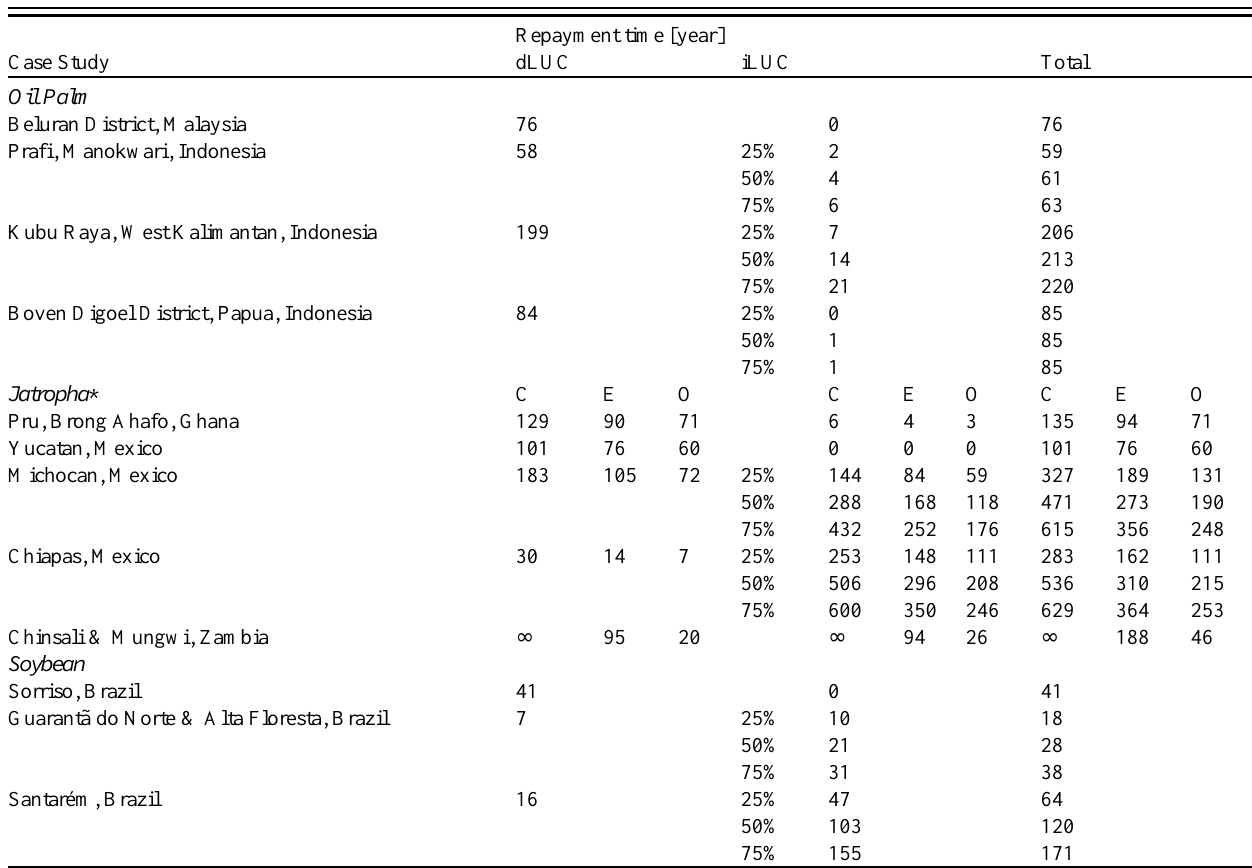
Table 4. Repayment times [years] for direct (dLUC), indirect (iLUC), and total land-use